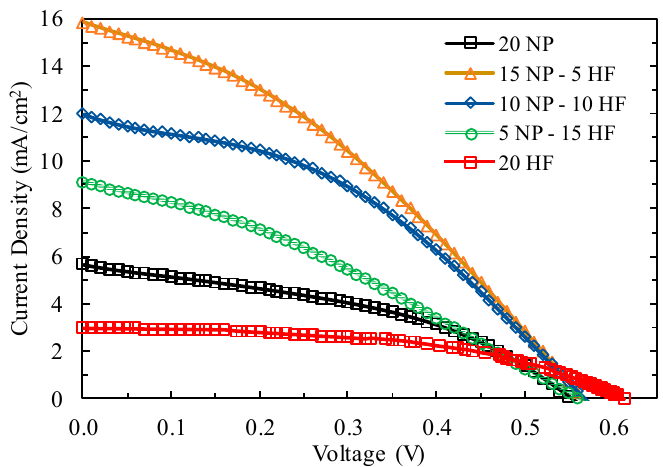
Figure 5. I-V curves of DSSCs under irradiation intensity of 100 mW/cm 2 .